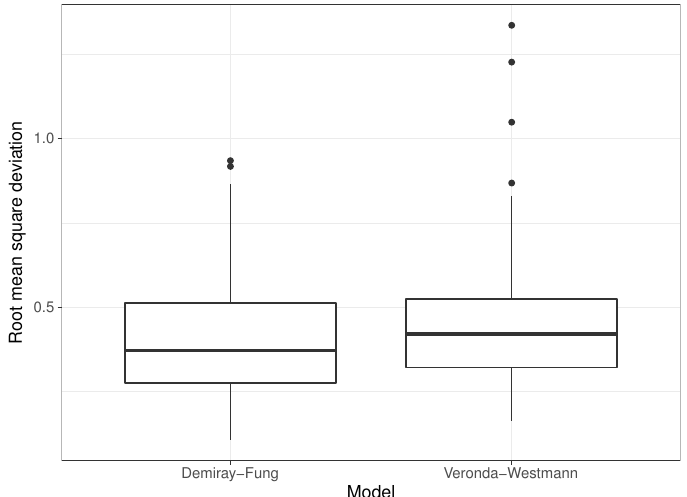
Figure 16. Distribution of root mean square deviation of predicted elastogram with measured elastogram for DF and VW.